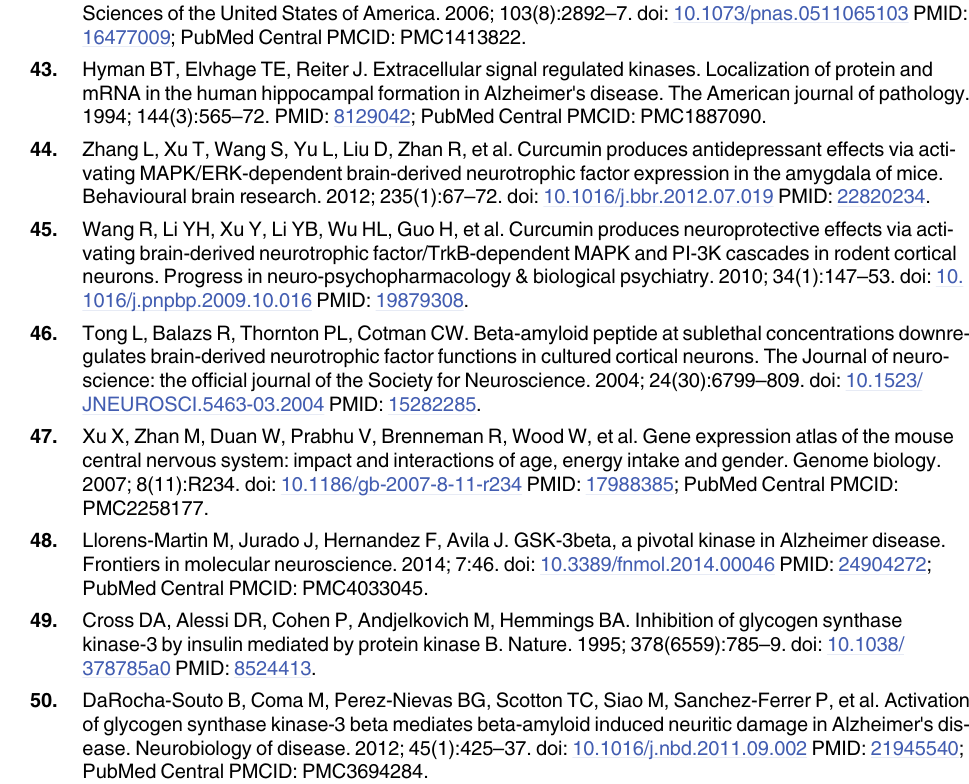
PLOS ONE | DOI:10.1371/journal.pone.0131525 June 26,